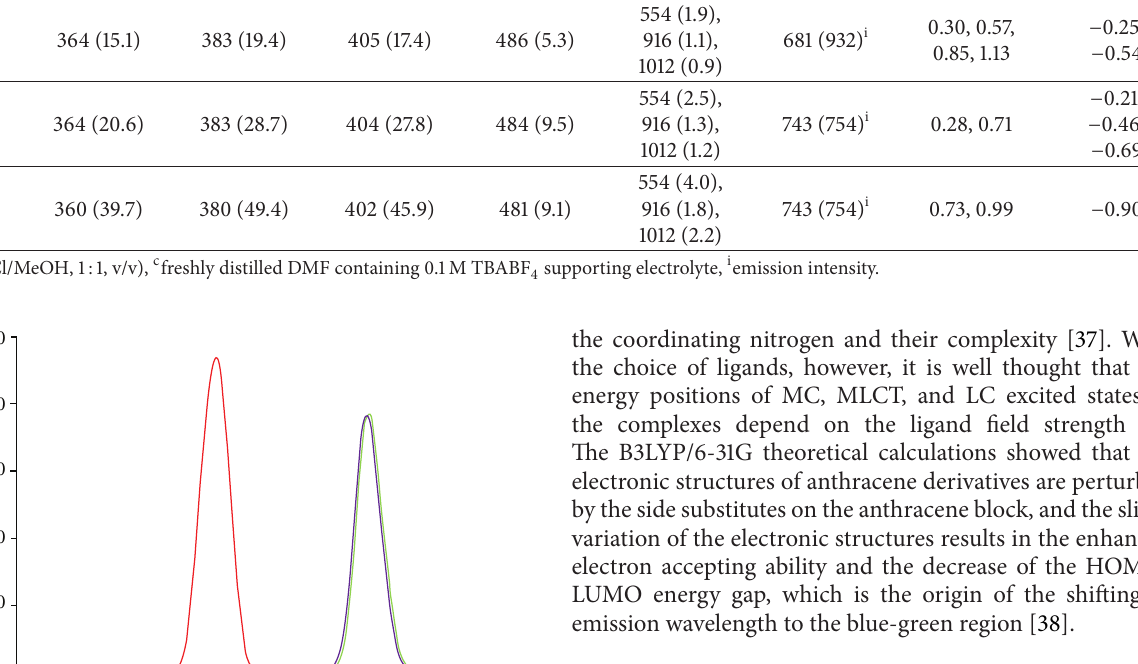
Table 1: Photophysical properties and electrochemical data of RBT1 , RBT2, and RBT3 complexes. Complex